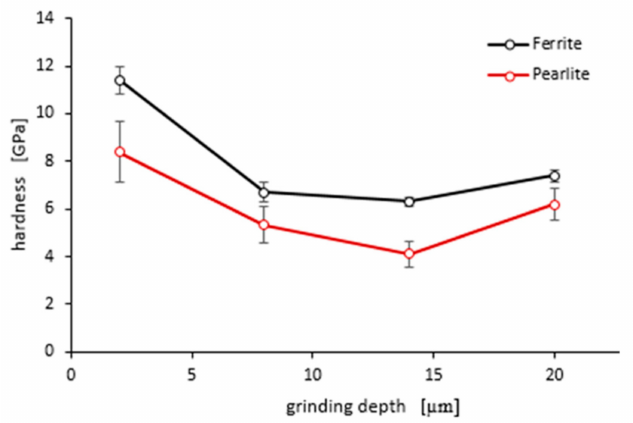
Figure 17. An average hardness of ferrite and pearlite grains after grinding to di ff erent depths. Error bars show ± standard